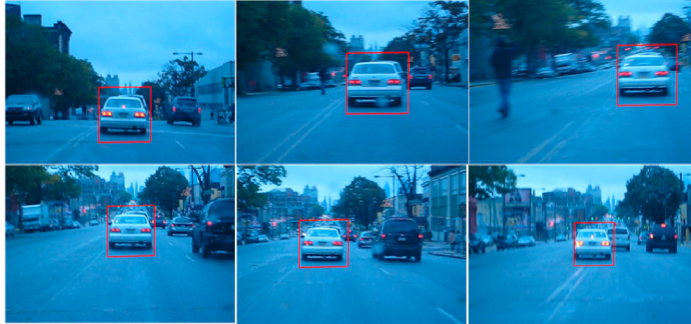
Figure 8. Tracking of Vehicle (Data Set: Blur